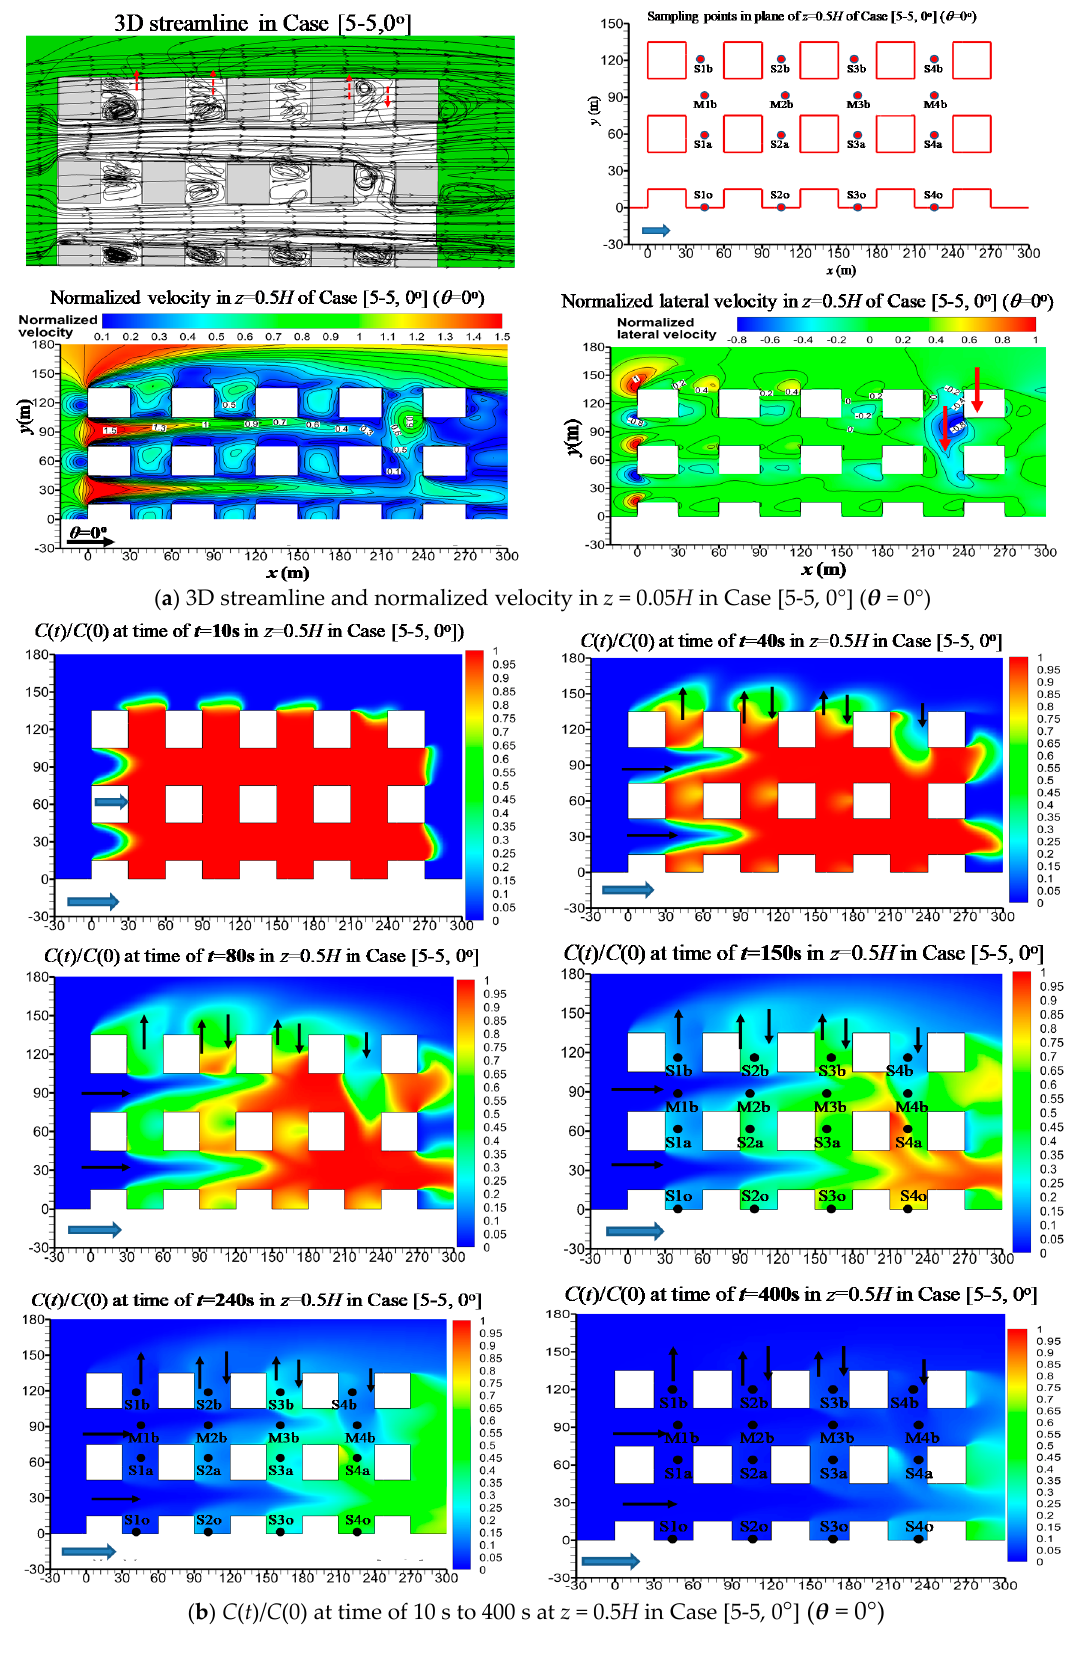
Figure 4. In Case [5-5, 0°] ( θ = 0°): ( a ) 3D streamline and normalized velocity in z = 0.05 H ; ( b ) C ( t )/ C (0) at time of 10 s to 400 s in plane of z = 0.5 H .